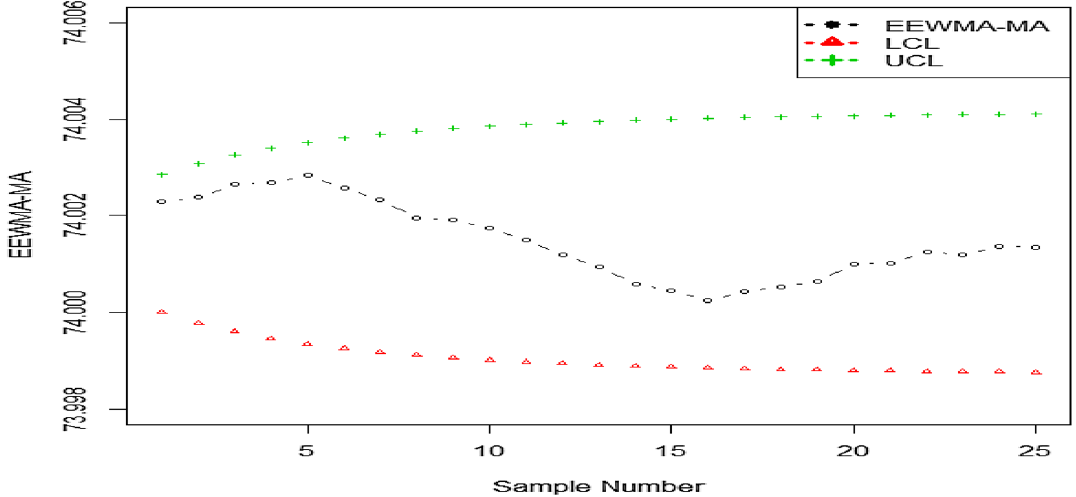
Figure 3. Graph of real-life data of proposed EEWMA-MA